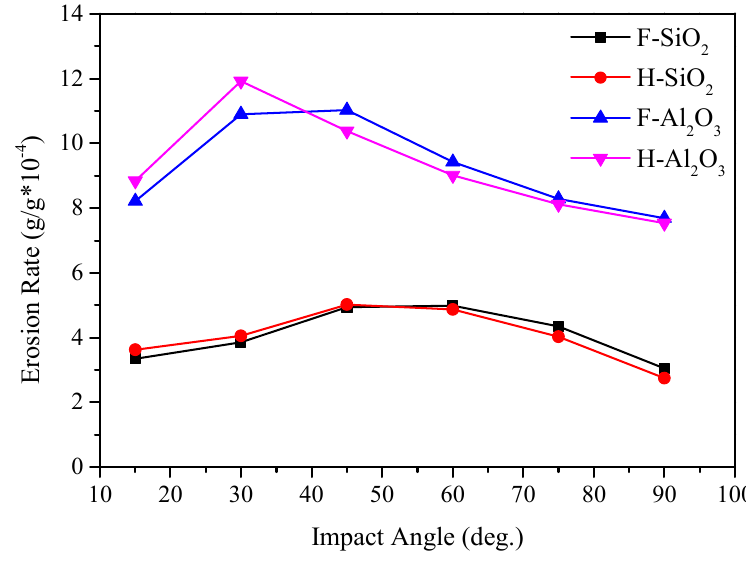
Figure 12. Erosion rate of XK105-F and XK105-H.